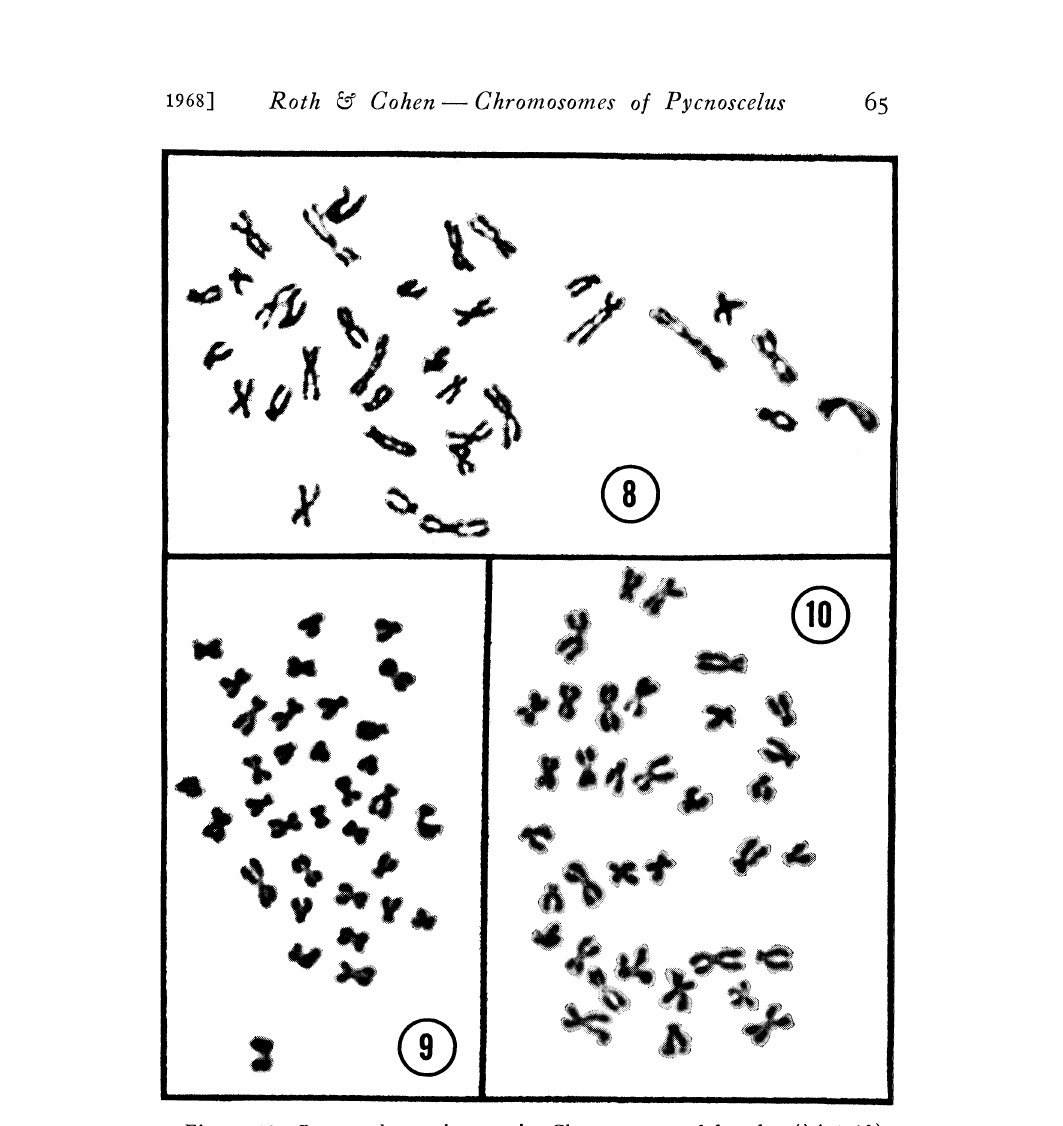
Figs. 8-10. Pycnoscelus surinamensis. Chromosomes of females (X 1300). 8. From Petchburi County (Thailand), 34 chromosomes. 9. From Serra Tamendaui (Brazil), 34 chromosomes. 10. From Pak Thong Chai County (Thailand), 35